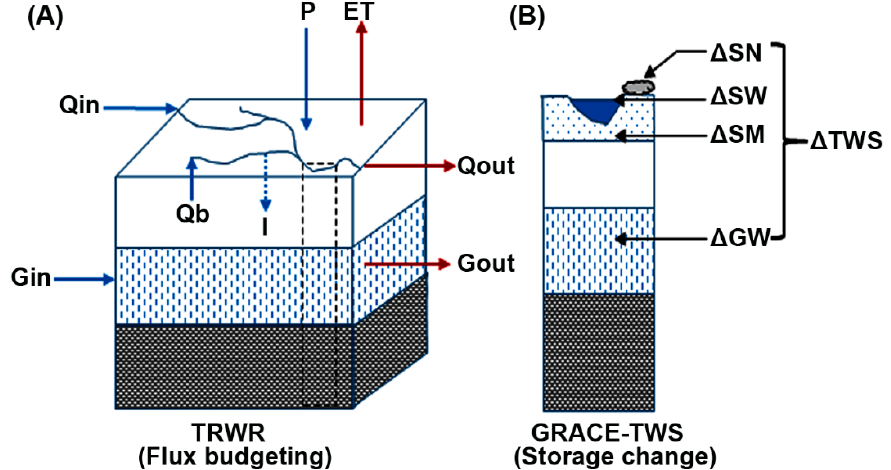
Figure 1. A conceptual framework to estimate the net water storage using flux budgeting ( A ) as the difference between the input-output of the water in the system and Gravity Recovery and Climate Experiment (GRACE)-based changes in water storage ( B ). TRWR: Total Renewable Water Resources;